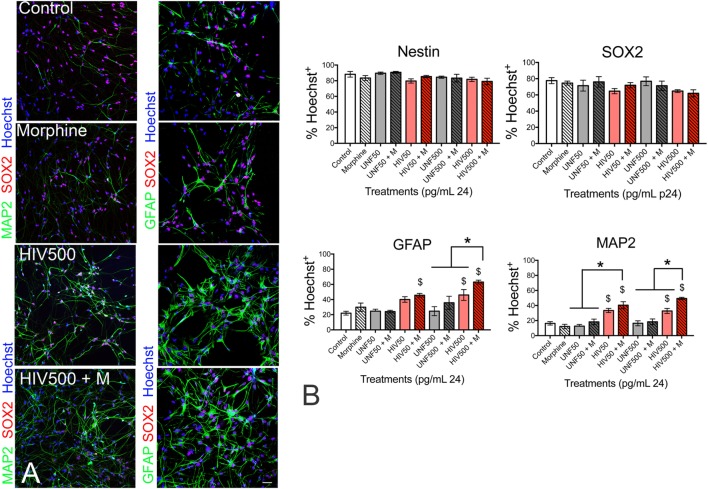
HIV-1 ± morphine co-exposure promotes immature neural progenitor cells (NPCs) to become neurons and astrocytes. (A) Representative immunostaining of SRY-Box 2 (SOX2—a marker of undifferentiated NPCs; red fluorescence), microtubule-associated protein 2 (MAP2—a neuronal marker; green fluorescence—left-hand panel), and glial fibrillary acidic protein (GFAP—an astroglial marker; green fluorescence—right-hand panel) in human NPCs treated with morphine (500 nM), spent medium (supernatant) from HIV-1-infected (HIVsup) peripheral blood mononuclear cells (PBMCs) containing 500 pg/ml of the HIV-1 p24 capsid protein alone (HIV 500) or with morphine (HIV 500 + M) for 12 days in cell culture. (B) Analysis of human NPCs continuously treated with morphine, HIVsup at 50 pg/ml p24 (HIV 50), 500 pg/ml p24 (HIV 500) alone or with morphine (M), and equal dilutions of supernatant from uninfected PBMCs (UNF50 or UNF500) alone or with morphine (M). The percentage of NPCs expressing nestin (transiently expressed by immature neural cells), SOX2, MAP2, and GFAP from each treatment group was calculated from >200 cells per study. Error bars show mean ± SEM from n = 5 separate studies each using NPCs derived from independent tissue samples. $p < 0.05 versus control; *p < 0.05. Reprinted from Ref. (279); Copyright (2017), with permission from Wolters Kluwer Health, Inc.